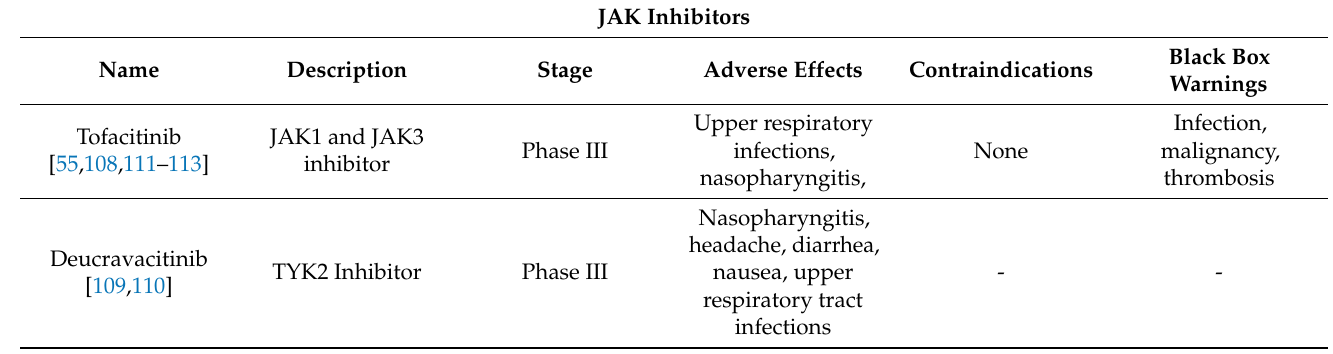
Table 6. Summary of Oral JAK